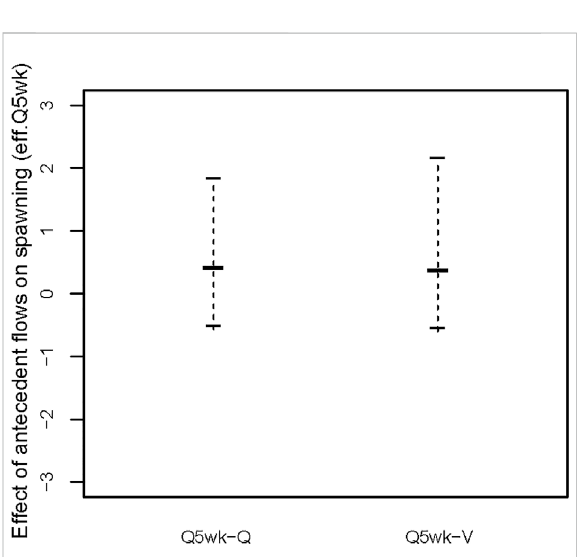
FIGURE 7 Effects of 5-week antecedent fl ows ( eff.Q 5 wk ) on ability to spawn, for each of the two model structures that include the antecedent fl ows, as described for Figure 5. The plot shows the hyperparameter estimate for eff. Q 5 wk across the four sites, but all site-level estimates show similar patterns. Horizontal bars showthemedianparameterestimatewithwhiskersencompassing the 95% credible interval for the